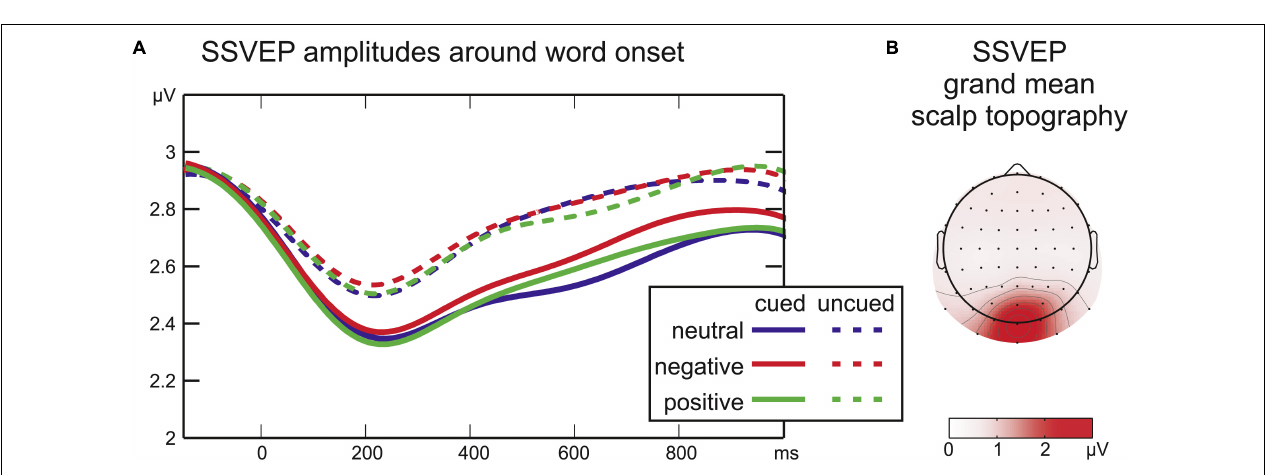
FIGURE 2 | (A) ERP time course at the five central electrodes chosen to analyze the SPN amplitude, indicated on the scalp electrode map at the right side of the panel. Note that condition effects continue after the cue period throughout the stimulus period. (B) Difference maps for the SPN time window (1000 ms before word onset) reveal a larger central negativity prior to emotional words, especially negative words (upper scalp map).